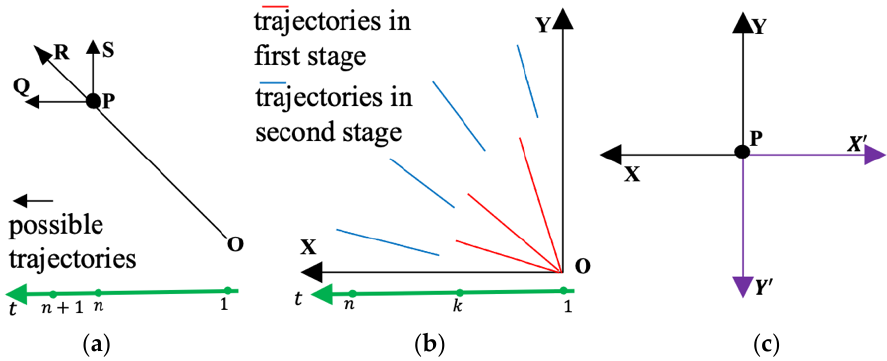
Figure 6. Redundant and sparse trajectories: ( a ) redundant trajectories; ( b ) sparse trajectories; and ( c ) target search area and its opposite area.